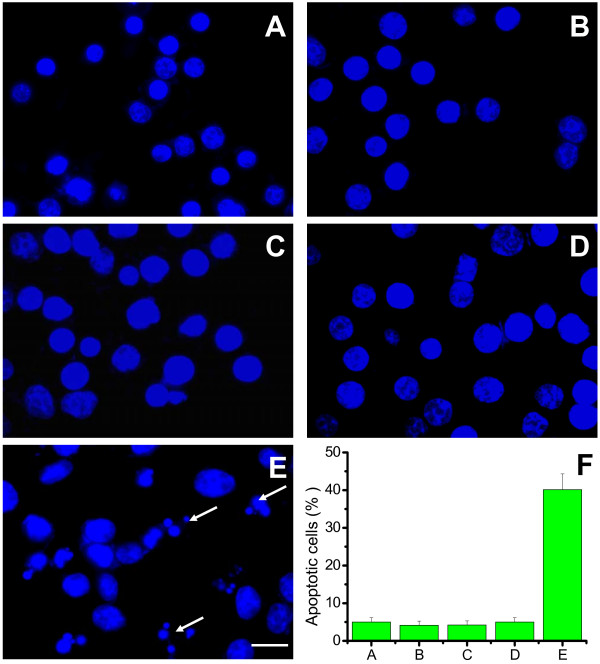
Hoechst staining of cells in the presence of amyloid-like tau. Treatment with formaldehyde-treated tau resulted in apoptotic death. Note that formaldehyde was removed from the protein samples by ultrafiltration. SH-SY5Y cells were treated for 3 days with tau deposits (2 μM) induced by pretreatment with 0.1% formaldehyde. The cells were collected and stained with Hoechst 33258. Nuclei were visualized by fluorescence microscopy. Bar: 25 μm. (A) Control culture in DMEM without serum. (B) Cells treated with self-aggregated tau. (C) Cells treated with 0.1 %-acetaldehyde-treated tau. (D) Cells treated for 72 h with the mock solution without formaldehyde were collected and stained with Hoechst 33258. (E) Cells treated with 0.1 %-formaldehyde-treated tau. The arrows designate the presence of apoptotic nuclear profiles. Data are expressed as a percentage of the control (cells treated with vehicle alone) and presented as the mean ± SEM (n = 6). (F) Statistics of apoptotic cells from A-E.